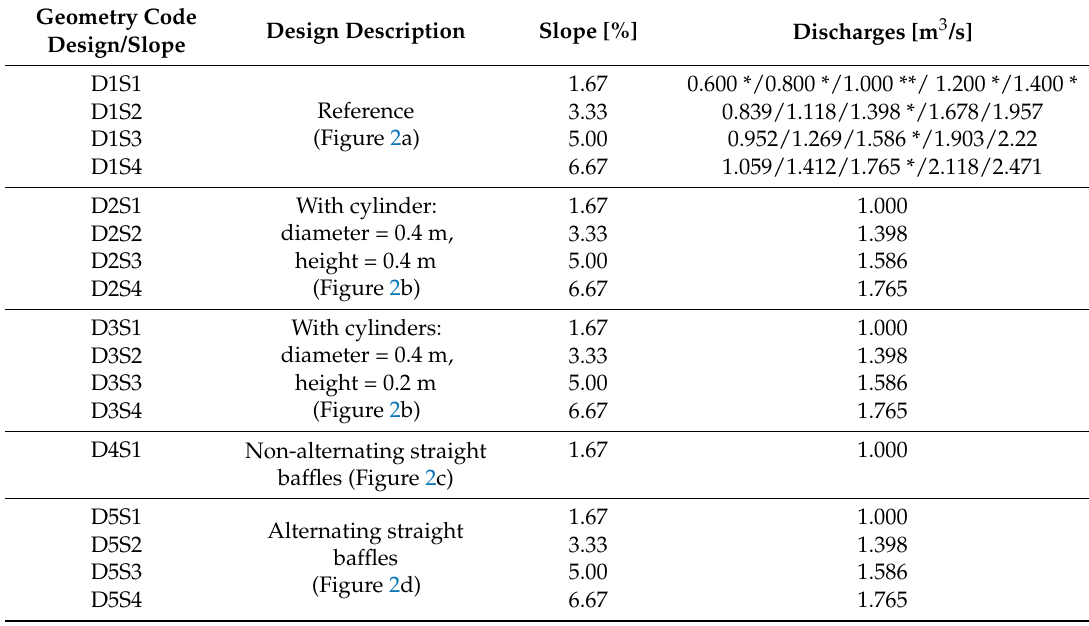
Table 1. Characteristics of all